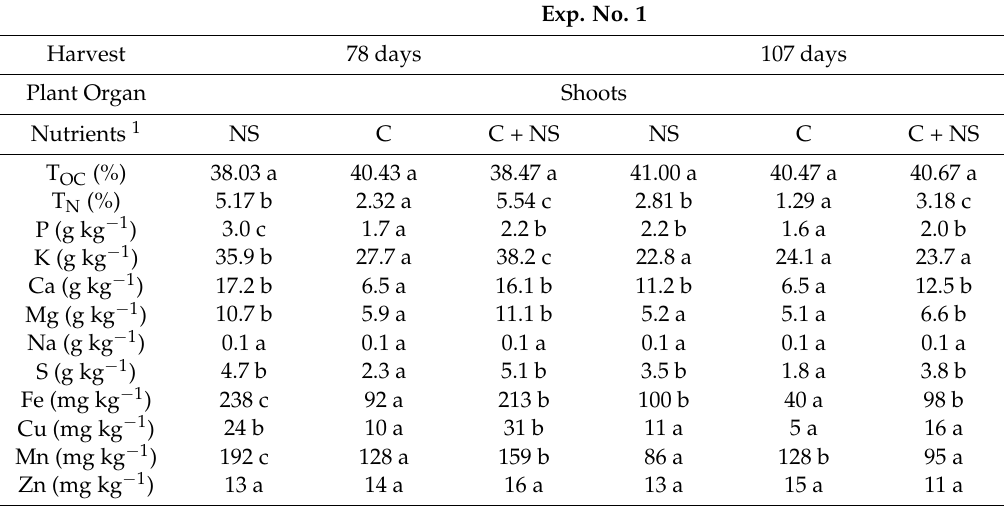
Table 3. Macro and micronutrient concentrations in pepper shoots and fruits from Exp. No. 1 according to each harvest and treatments. NS, plants grown with full nutrient solution; C, plants only grown with compost; C + NS, plants grown with compost and complemented with full nutrient solution. Exp. No. 1